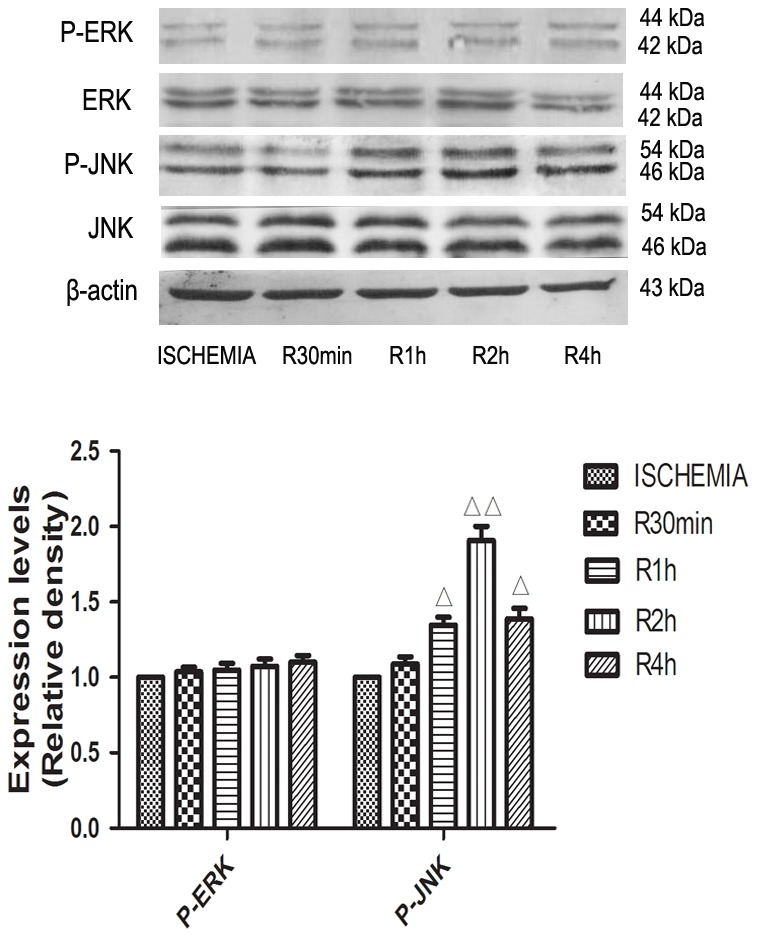
The effects of different reperfusion time on p-ERK and p-JNK.Cardiomyocytes were cultivated for 13(0.5 h, 1 h, 2 h, 4 h), the influence of different time of reperfusion on p-ERK(44 KDa, 42 KDa) and p-JNK(54 KDa, 46 KDa) was monitored. All data were expressed as mean ±SEM, n = 3, △P<0.05, △△P<0.01 versus ISCHEMIA group.